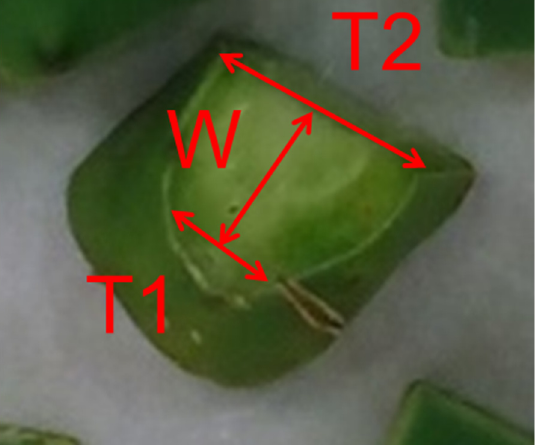
Figure 3. Cubes made from cutting prickly-pear cladodes. T 1 = thickness of the cube face at the thickest point; T 2 = thickness of the cube face at the narrowest point; W = average length of the face.